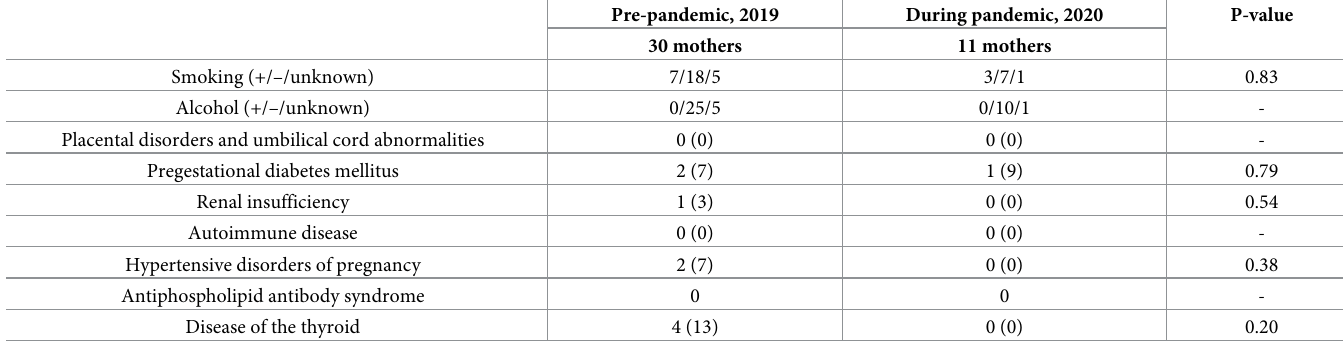
Table 4. Maternal factors associated with fetal growth